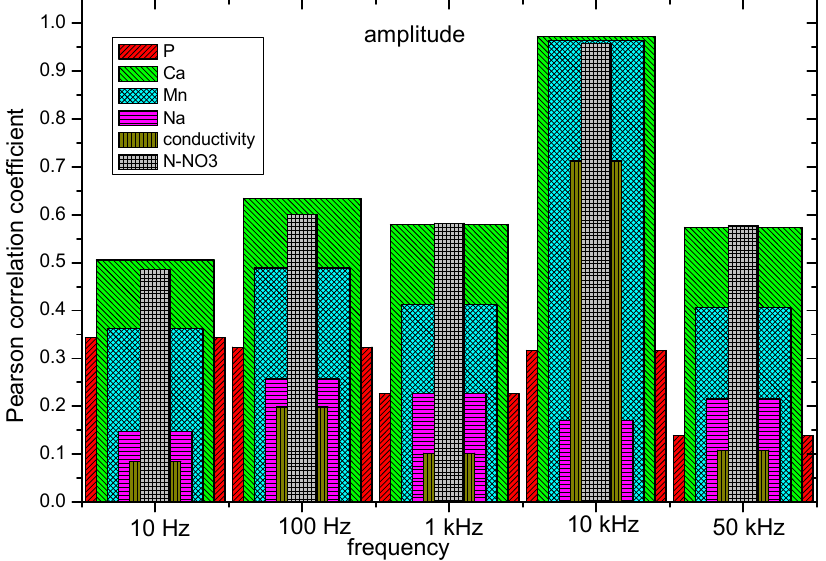
Figure 15. Pearson correlation coefficient of P, Ca, Mn, Na, conductivity, and N 2 -NO 3 with respect to the amplitude in the range of frequencies of 10 Hz, 100 Hz, 1 KHz, 10 KHz, and 50 KHz.